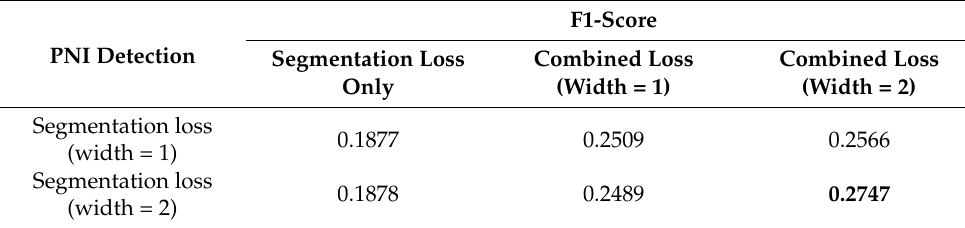
Table 1. Average F1-score on test sets for PNI